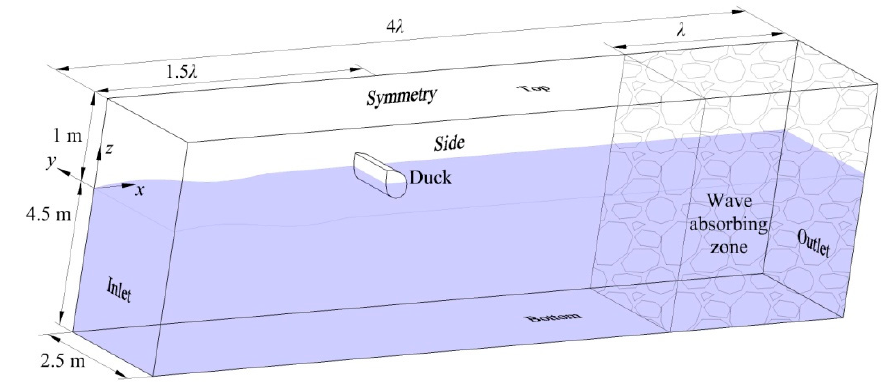
Figure 3. Geometry of the numerical wave tank.